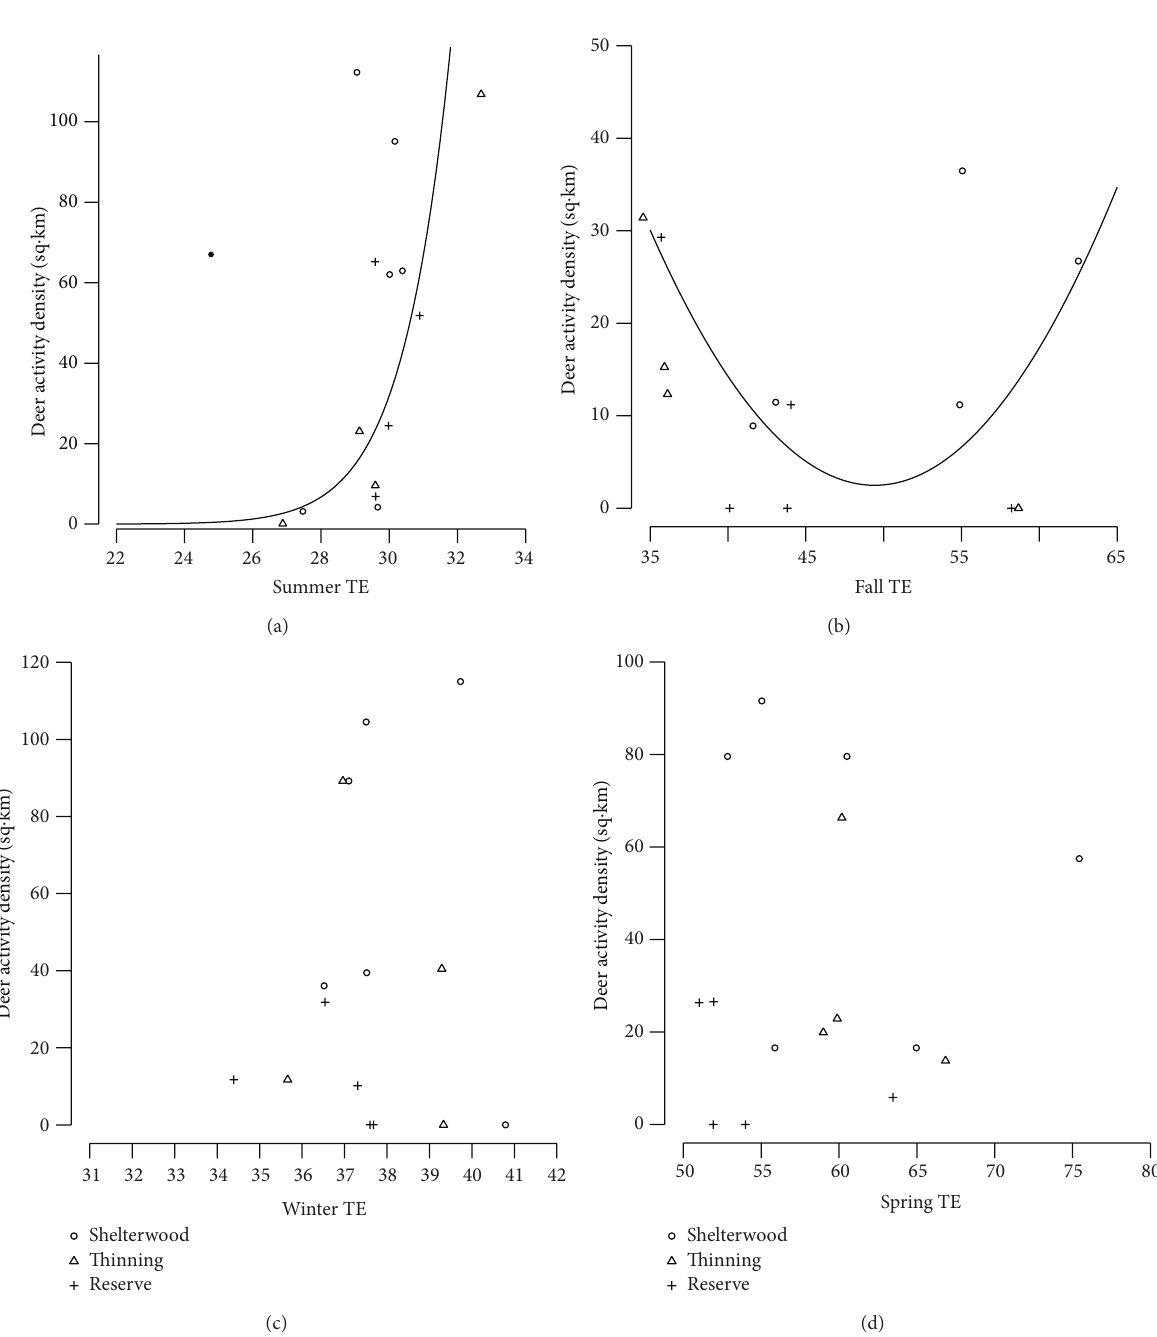
but not during the winter and spring. Even though